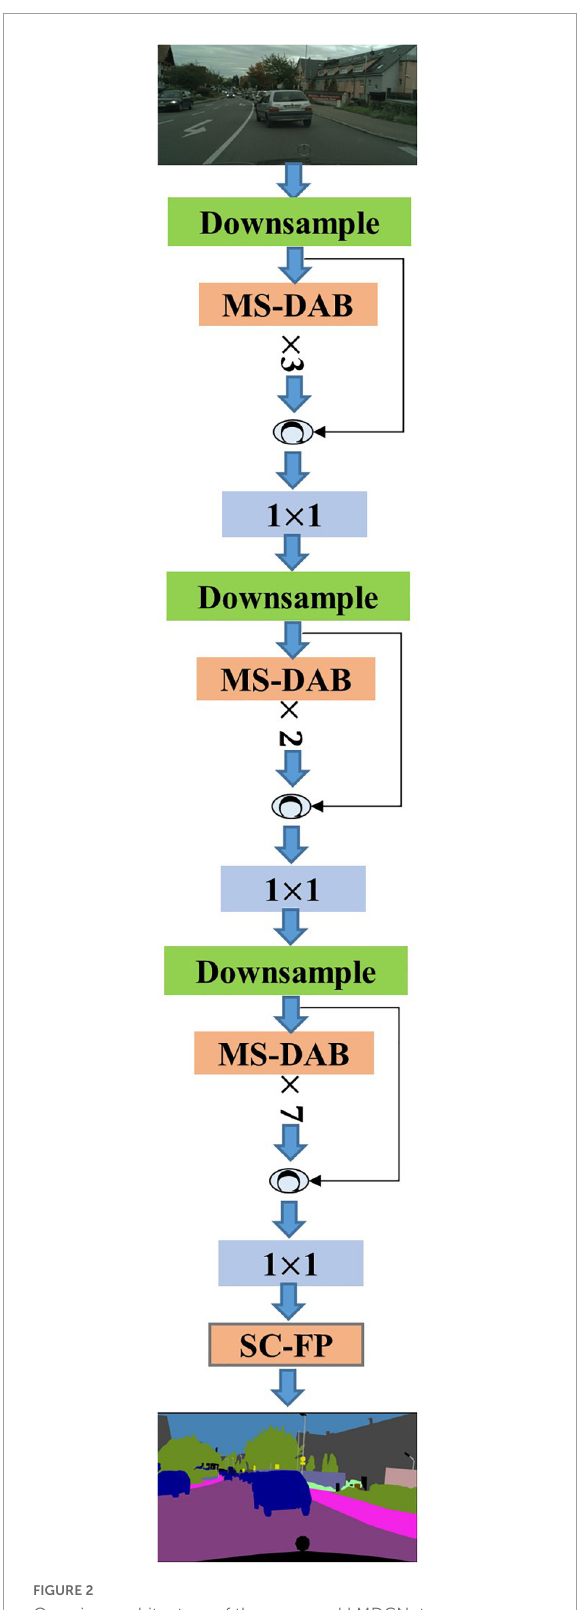
FIGURE2 Overview architecture of the proposed